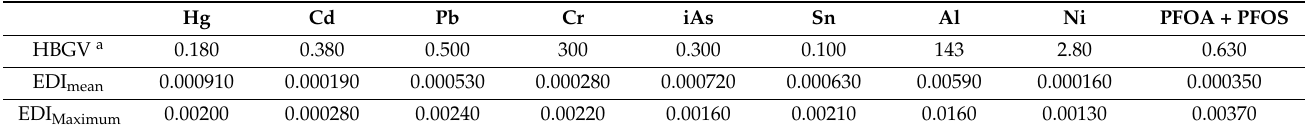
Table 8. Data relating to the characterization of the risk from oral exposure to the studied elements through the consumption of preserved anchovies (HBGVs and EDIs of elements expressed as µ g kg −